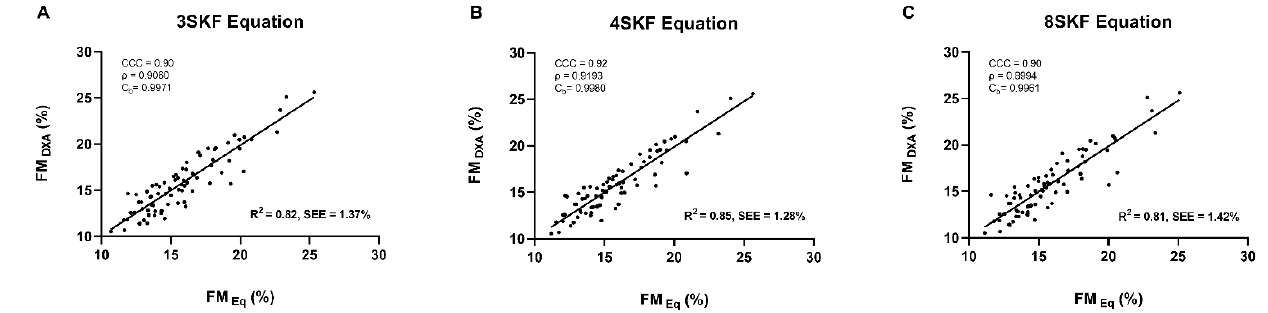
Figure 1. The least squares regression (R 2 , coefficient of determination; SEE, standard error of the estimate) and concordance coefficient of correlation (CCC), including the precision (ρ) and accuracy (C b ) analyses of the fat mass percentage from the reference method (FM DXA (%)) vs. the novel prediction equations (FM Eq (%)) in high-level male futsal players ( n = 78). The plots indicate the line of regression. The prediction equations are ( A ) the sum of three skinfolds (triceps, abdominal, and front thigh), waist girth; ( B ) the sum of four skinfolds (triceps, iliac crest, abdominal, and front thigh), waist girth; ( C ) the sum of eight skinfolds (triceps, subscapular, biceps, iliac crest, supraspinale, abdominal, front thigh, and medial calf), waist girth. No significant differences between the reference and predicted fat mass percentage by any of the equations (all p > 0.05).